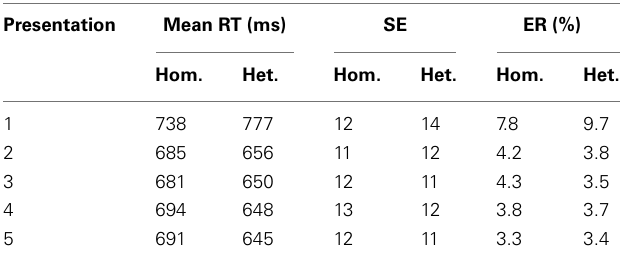
Table 1 | Mean response times, standard errors of means, and mean error rates in semantically homogeneous and heterogeneous naming conditions.